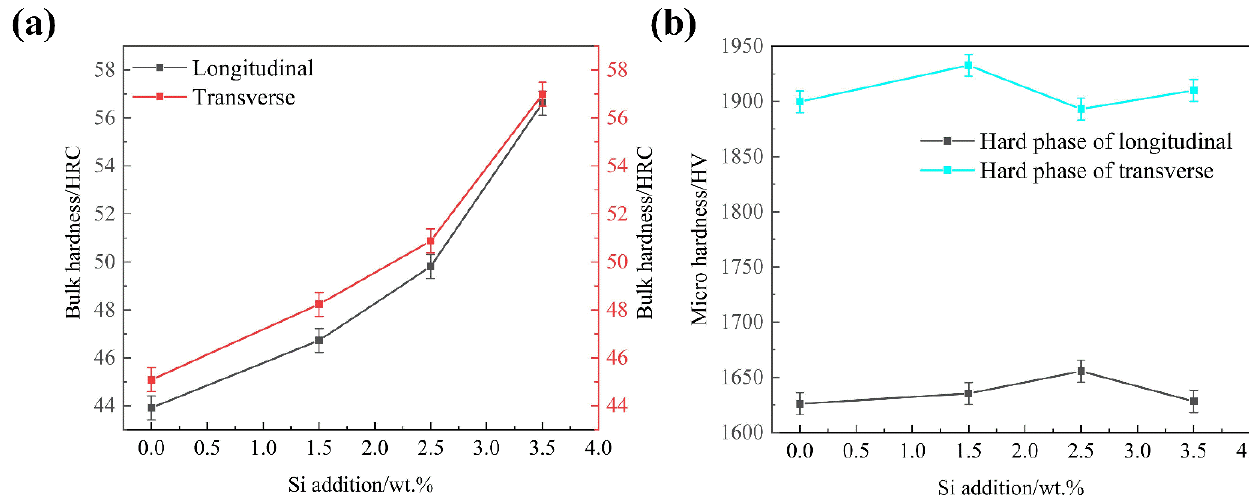
Figure 5. Bulk hardness and micro hardness of as-cast DS Fe-B alloy: ( a ) bulk hardness of longitudinal section and transverse sections, ( b ) microhardness of hard phase.